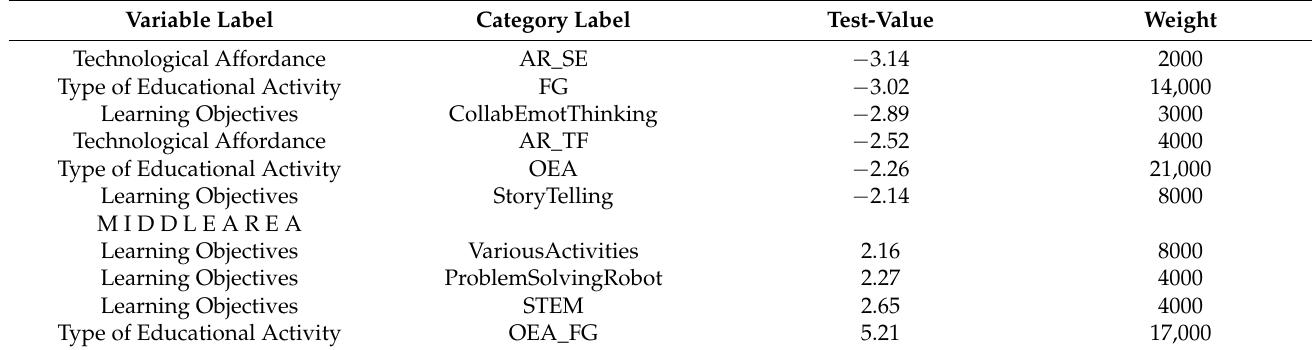
Table 5. Printout on factor 2 by the active variables.